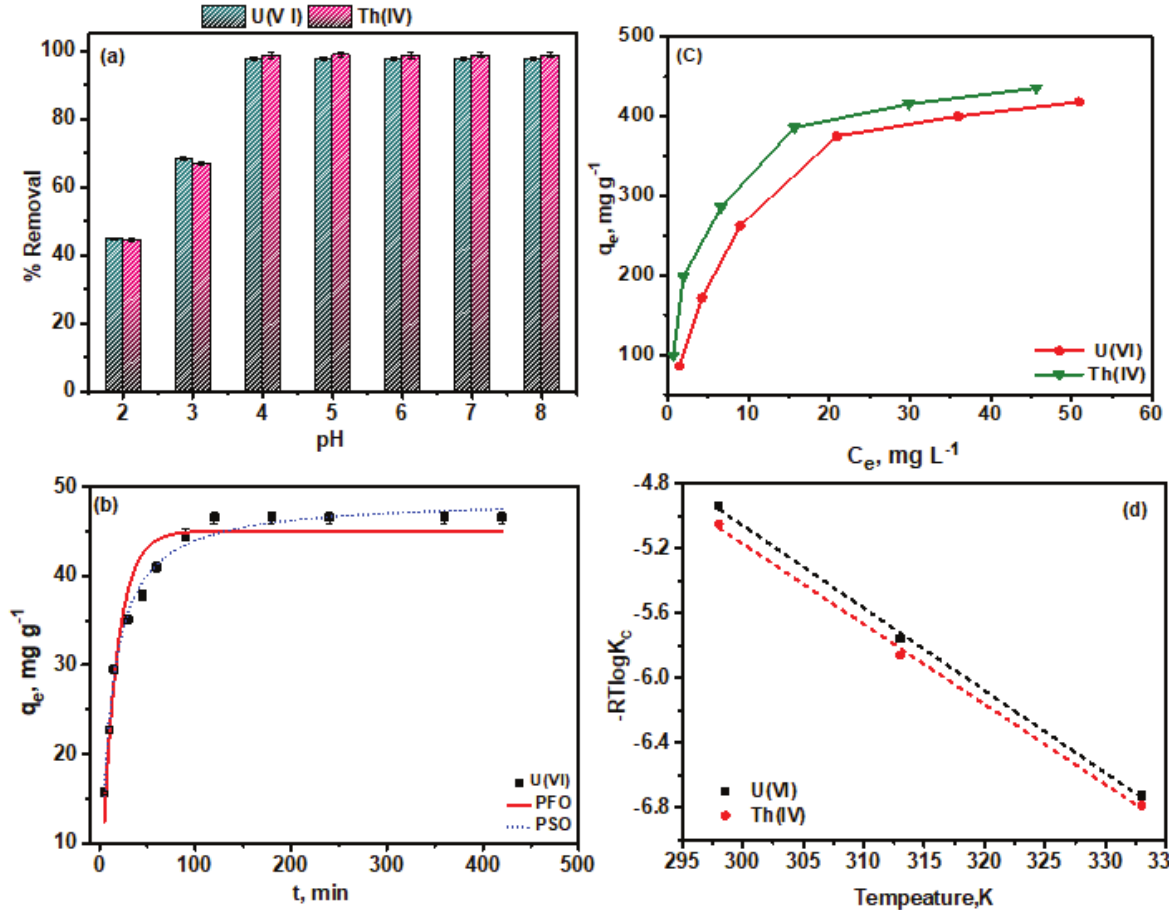
Figure 4. U(VI) and Th(IV) sequestration on PGO–Gd, ( a ) pH effect, ( b ) kinetic effect, ( c ) adsorption isotherms and ( d ) temperature effect.